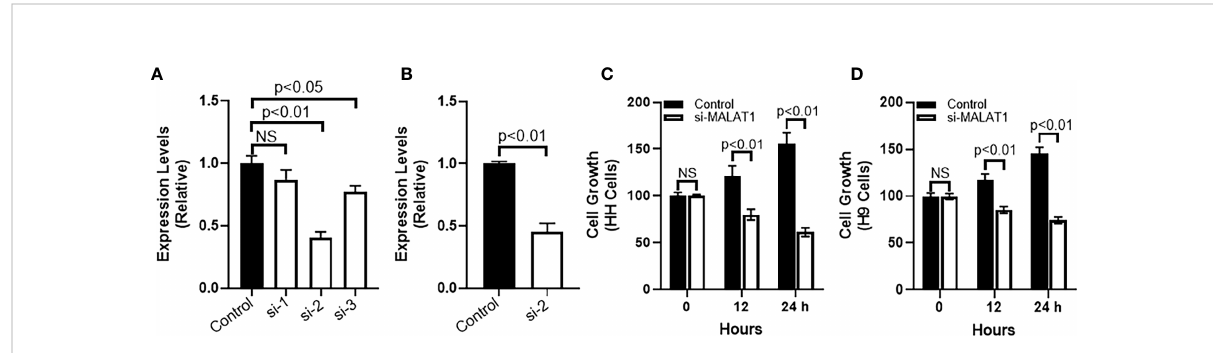
FIGURE 2 MALAT1 silencing in CTCL cells and its effects on cell growth. (A) Different siRNAs were checked for their ef fi cacy to inhibit MALAT1 in HH cells. (B) siRNA#2 was further evaluated in H9 cells. Cell growth was assessed by CCK-8 method in HH (C) and H9 (D) cells. NS is ‘ not signi fi cant ’